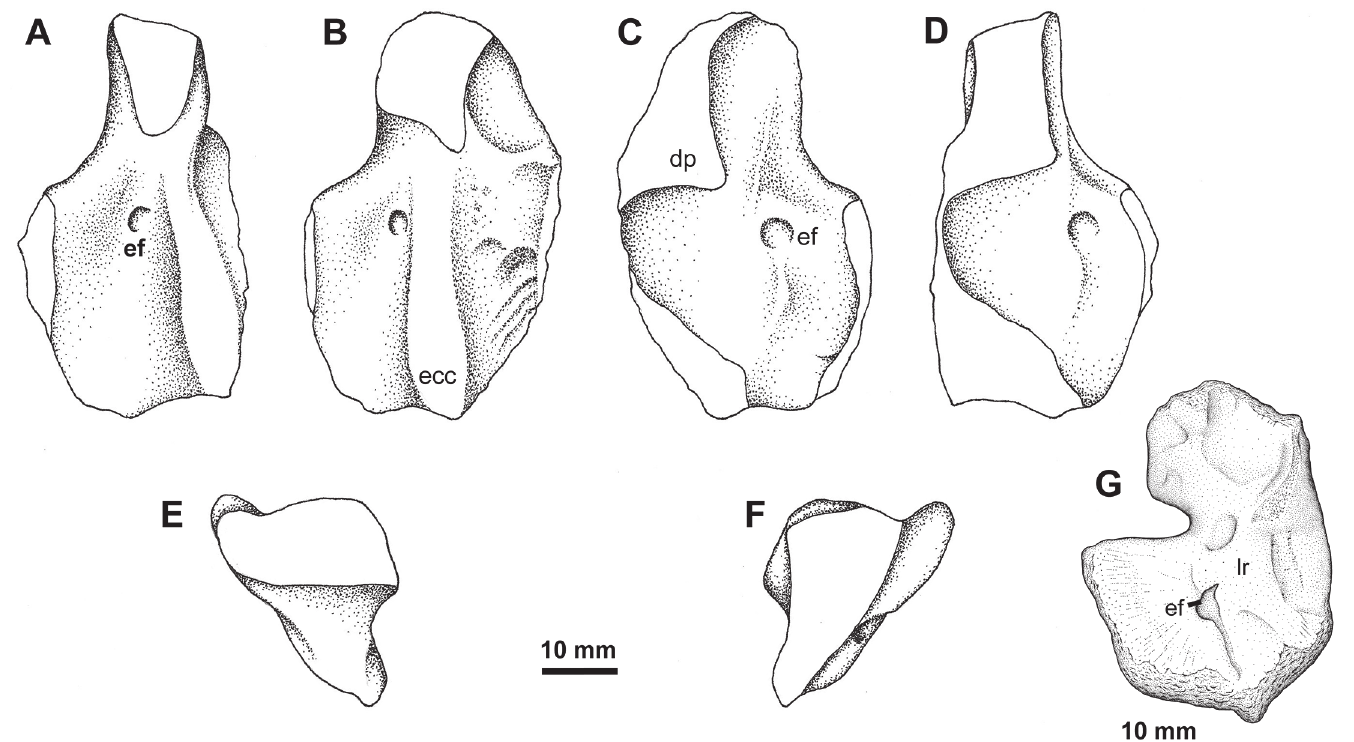
Fig 3. Humerus Type 1. A-F, YPM PU 23545, right humerus in A, oblique posterior, B, dorsal, C, ventral, D, oblique ventral, E, proximal, and F, distal views. G, NSM007GF004.634, small left humerus in ventral view. Abbreviations : dp , deltopectoral crest; ecc , ectepicondyle; ef , entepicondylar foramen; lr , longitudinal